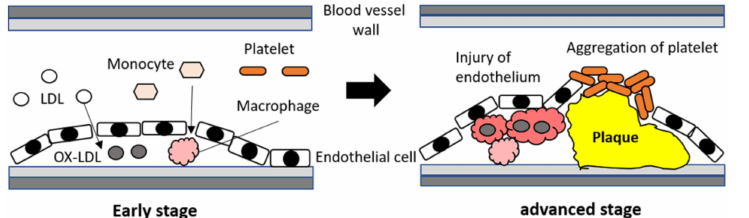
Figure 1. Summary of the pathological roles of oxidized low-density lipoprotein and macrophages in endothelial dysfunction and vascular